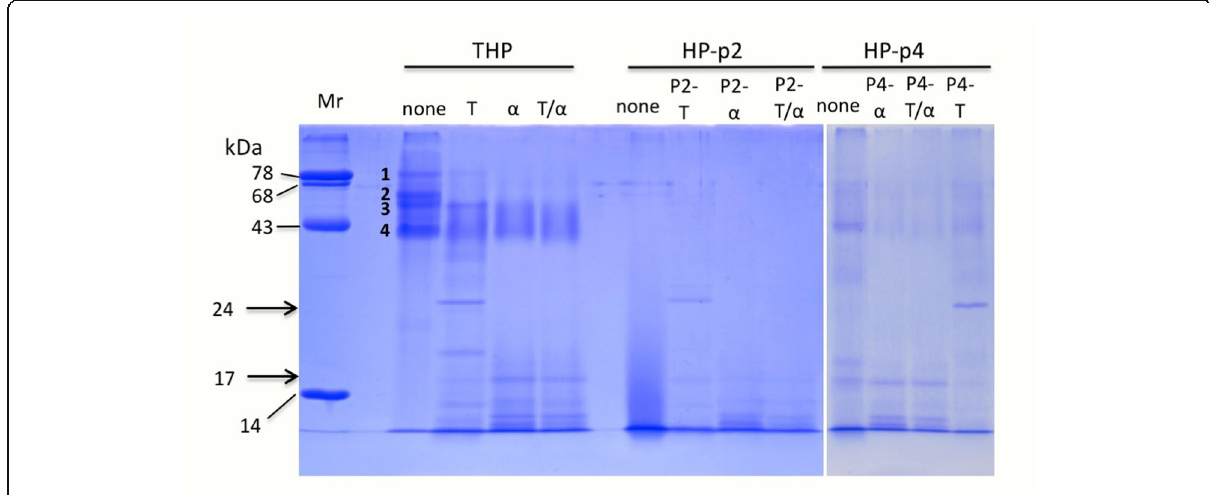
Fig. 1 SDS-PAGE of THP subjected to gastrointestinal digestion without pepsin (THP) or with peptic digestion at pH 2.0 (HP-p2) and pH 4.0 (HP- p4) on reducing SDS 15% polyacrylamide gel. Mr., molecular weight marker; none, intact THP or pepsin alone digests; α , T/ α and T, THP or peptic